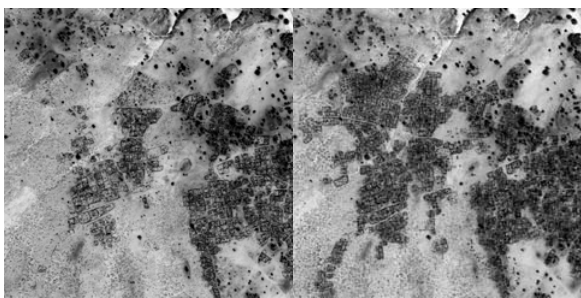
Fig. 2 Panchromatic Quickbird-2 images recorded on March 2, 2006 (left – before the attack) and on February 28, 2008 (right- after the attack) of the town Abu Suruj (2048 x 2048